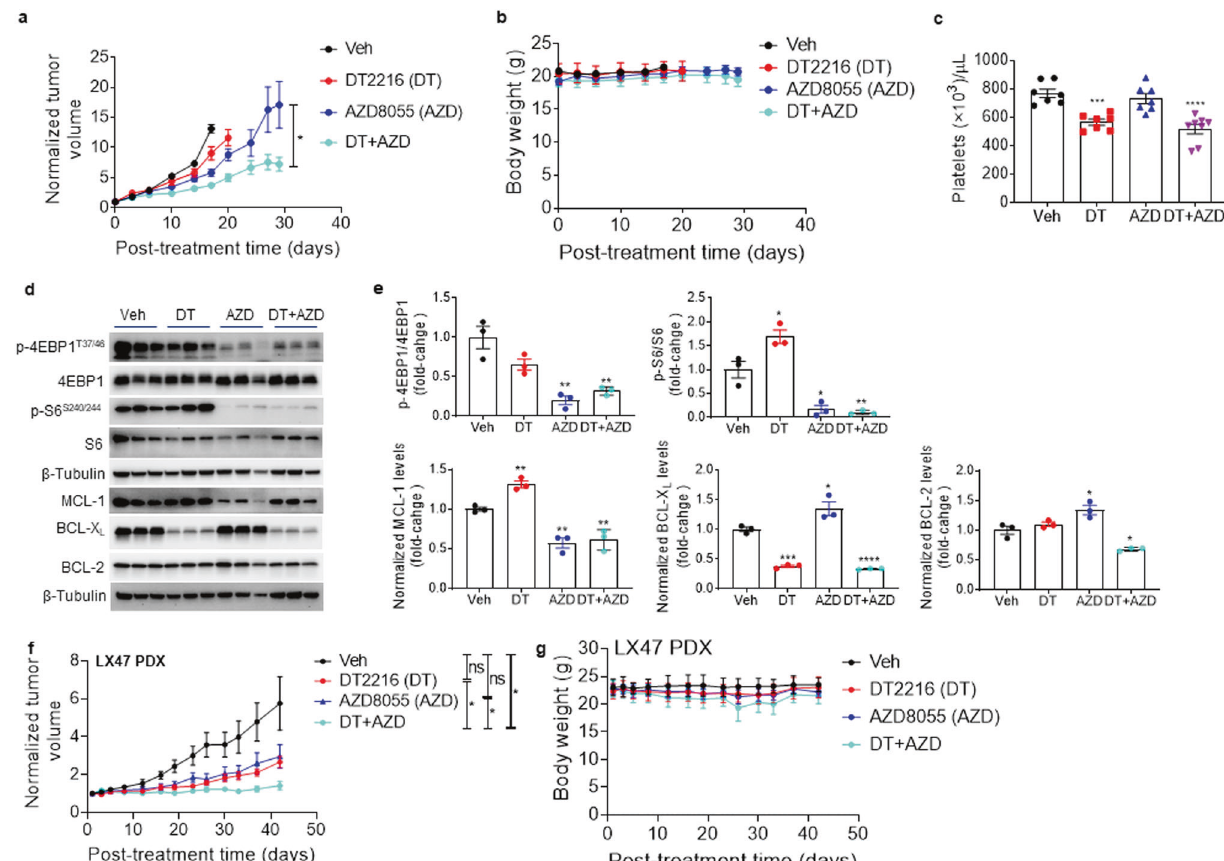
Fig. 5 The combination of DT2216 and AZD8055 has stronger antitumor responses in H1048 xenograft and SCLC PDX models. a , b Tumor volume ( a ) and mouse body weight ( b ) change in H1048 xenografts after treatment with vehicle (Veh), DT2216 (DT, 15 mg/kg/q4d, i.p.), AZD8055 (AZD, 16 mg/kg/5x week, p.o.) or a combination of DT and AZD. Data are presented as mean ± SEM ( n = 5 mice in Veh and single- treatment groups, and six mice in combination group at the start of treatment). c Platelet counts 24 h after the fi rst dose of DT2216 (DT, 15 mg/kg/q4d, i.p.) and/or AZD8055 (AZD, 16 mg/kg/5x week, p.o.) in H1048 xenograft mice from a separate experiment ( n = 7 mice in Veh and single-treatment groups, and eight mice in combination group). d Immunoblot analysis of indicated proteins in H1048 xenograft tumors at the end of treatments as in a ( n = 3 mice per group). e Densitometry of immunoblots shown in panel d (mean ± SEM). f , g Tumor volume ( f ) and mouse body weight ( g ) changes in LX47 PDX tumors after treatment with veh, DT2216 (DT, 15 mg/kg/q4d, i.p.) or AZD8055 (AZD, 16 mg/ kg/5x week, p.o.) or a combination of DT and AZD. Data are presented as mean ± SEM ( n = 8 mice in single-treatment groups, and nine mice in Veh and combination groups at the start of treatment). Statistical signi fi cance in a , c , e , and f was determined by a two-sided